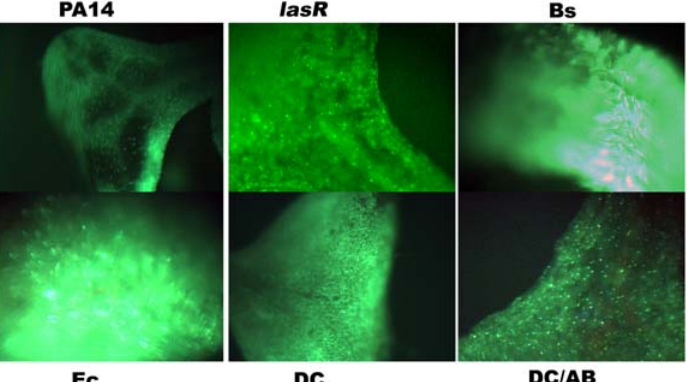
Figure 4. Higher magnification wide angle micrographs of membrane permeabilization in seedlings infected with different microbes. Wide angle microscopy of seedlings sytox green staining in green fluorescence channel. (100X magnification, except PA14 treated seedlings was imaged at 55X magnification). Seedlings were stained 3 dpi with membrane impermeable dye Sytox green (SG) and imaged in transparent bottom wells of 96 well plates.